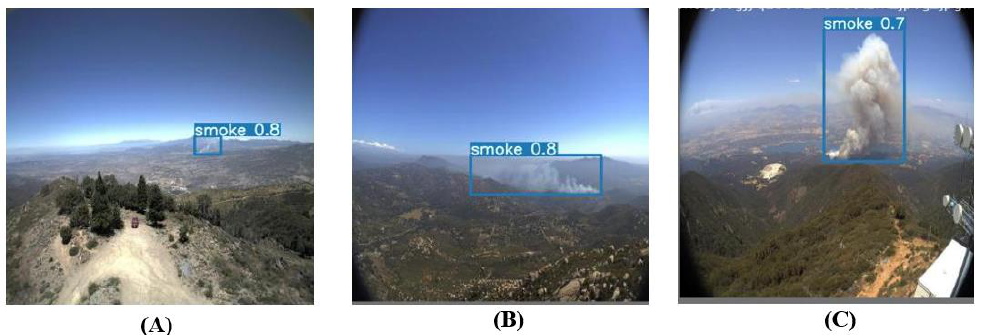
Figure 12. YOLOv7 detection areas results. ( A ) Far. ( B ) Medium. ( C ) Close.